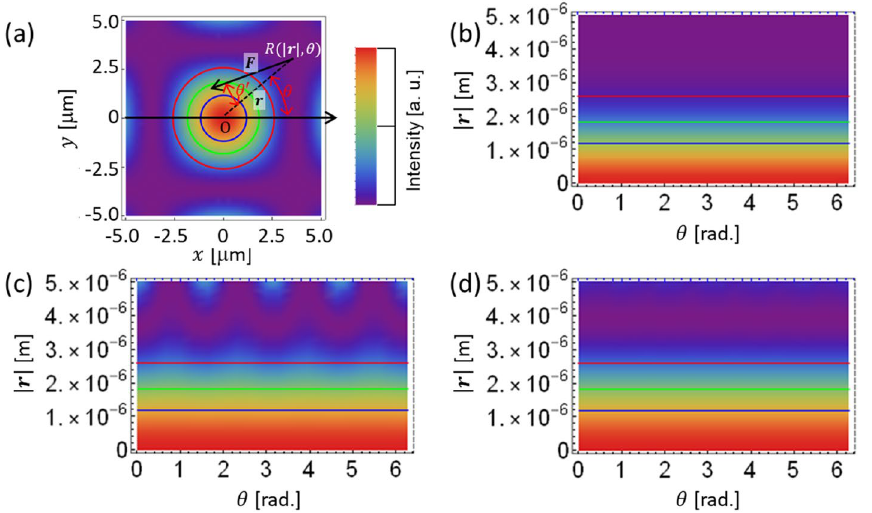
Figure 4. ( a ) Explanation of the light intensity distribution in a spot. This example corresponds to a 4-beam interference pattern. The concentric blue, green, and red circles represent respectively. An explanation of the deflection angle θ ′ of the radiation force F at R ( r , θ) is shown. ( b – d ) Variation of the light intensity in a Gaussian spot and 4- and 6-beam interference patterns versus declination r angle θ and , respectively. | |